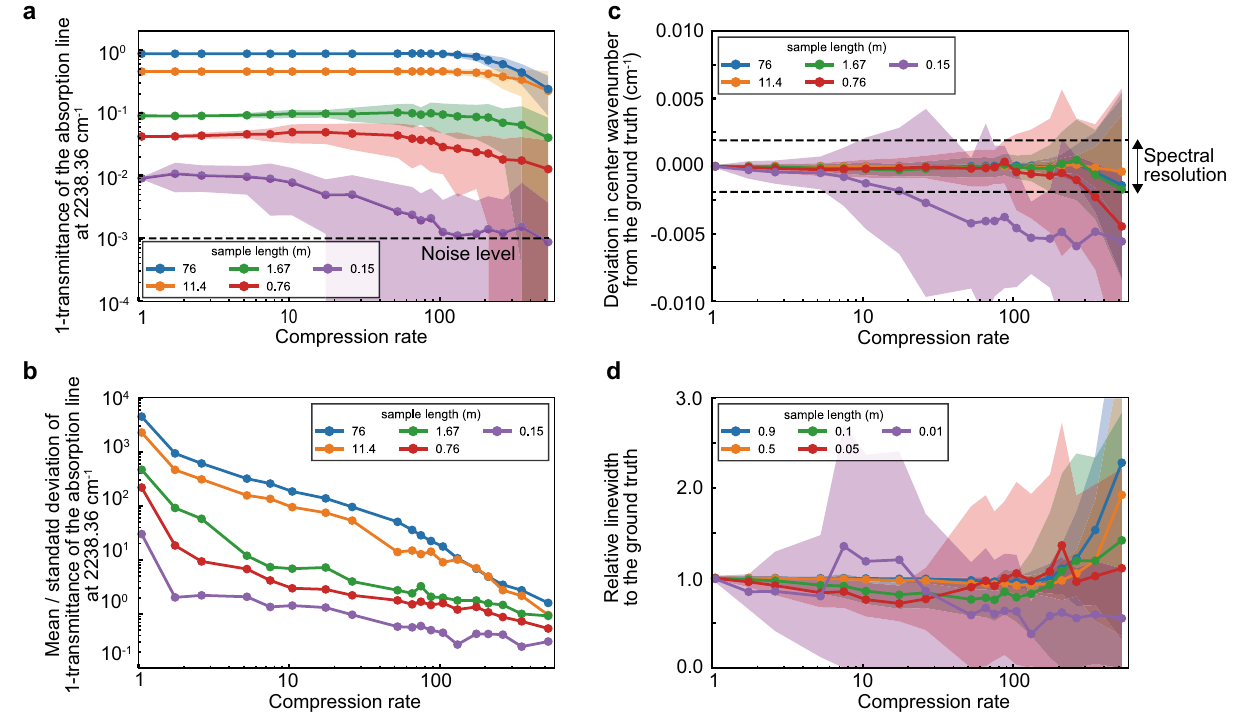
Figure 4. Robustness evaluation of CS reconstruction as a function of the compression rate. ( a ) peak transmittance. ( b ) mean/standard deviation of peak transmittance. ( c ) deviation in center wavenumber from the ground truth. ( d ) relative linewidth to the ground truth, of the absorption line at 2238.36 cm −1 . The plots with different colors show the calculation results with different sample lengths (blue: 76 m, yellow: 11.4 m, green: 1.67 m, red: 0.76 m, purple: 0.15 m). The dots and bands represent the mean values and standard deviations of the 100 spectra calculated with the different random